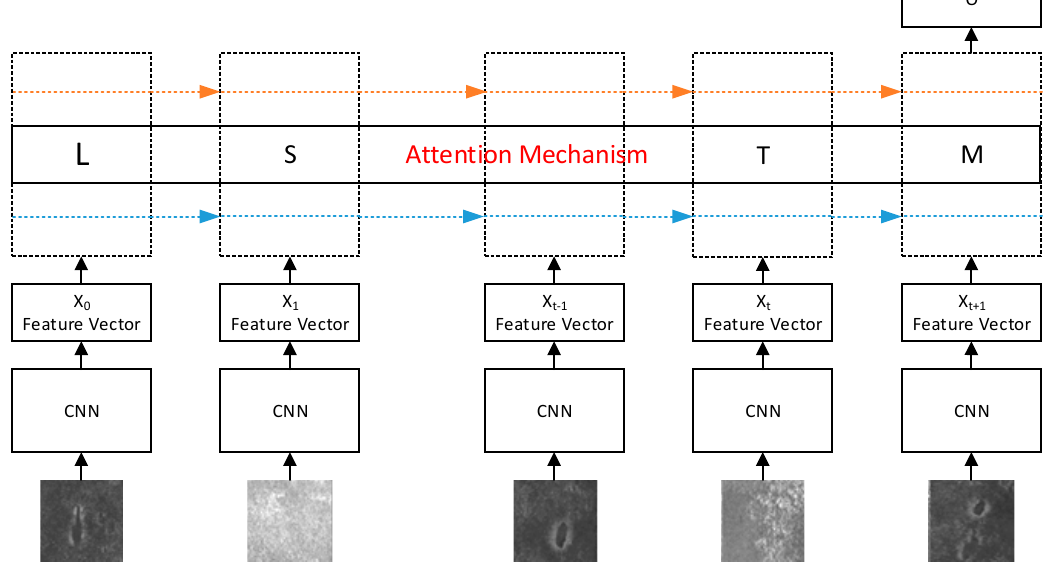
Figure 12. The network structure of the improved algorithm with the attention mechanism.